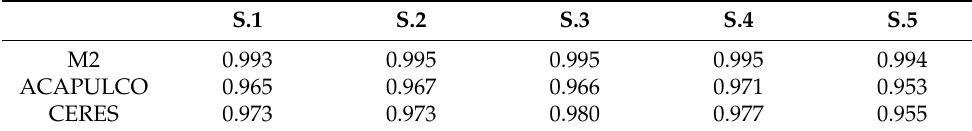
Table 9. SP comparison between our M2 model, ACAPULCO and CERES.